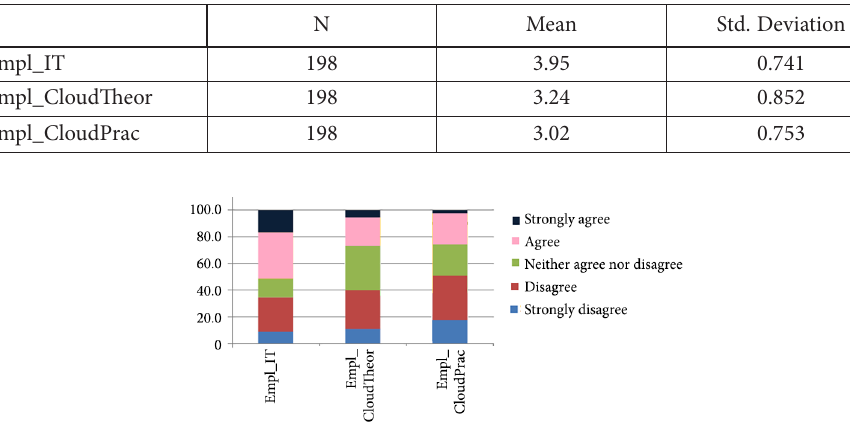
Figure 5. Respondents’ viewpoints regarding the variable employees’ know-how